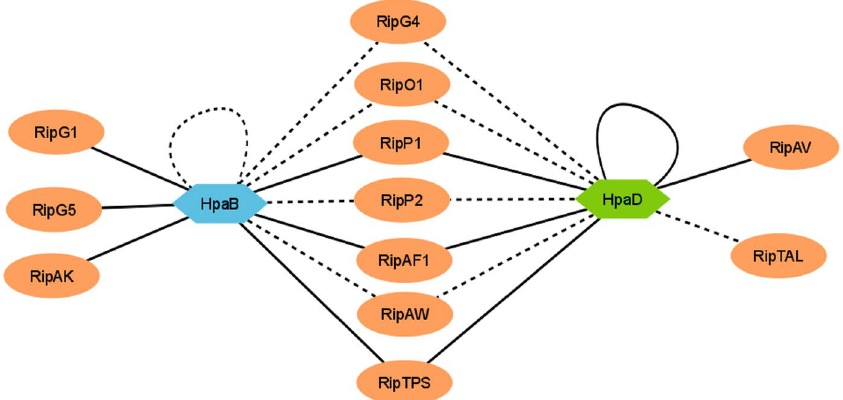
Figure 7. Type III interactome for HpaB and HpaD, two Class IB chaperones of R . solanacearum exhibit shared and specific T3E partners. This model shows that HpaB and HpaD are able to self-interact, and to interact with numerous T3Es. Solid black lines indicate interactions that have been confirmed by yeast two-hybrid and GST pull-down assays. Dotted black lines indicate interactions that have been identified by one of these two methods. The HpaB-HpaD interacting assays were negative with both methods. The model has been drawn using Cytoscape